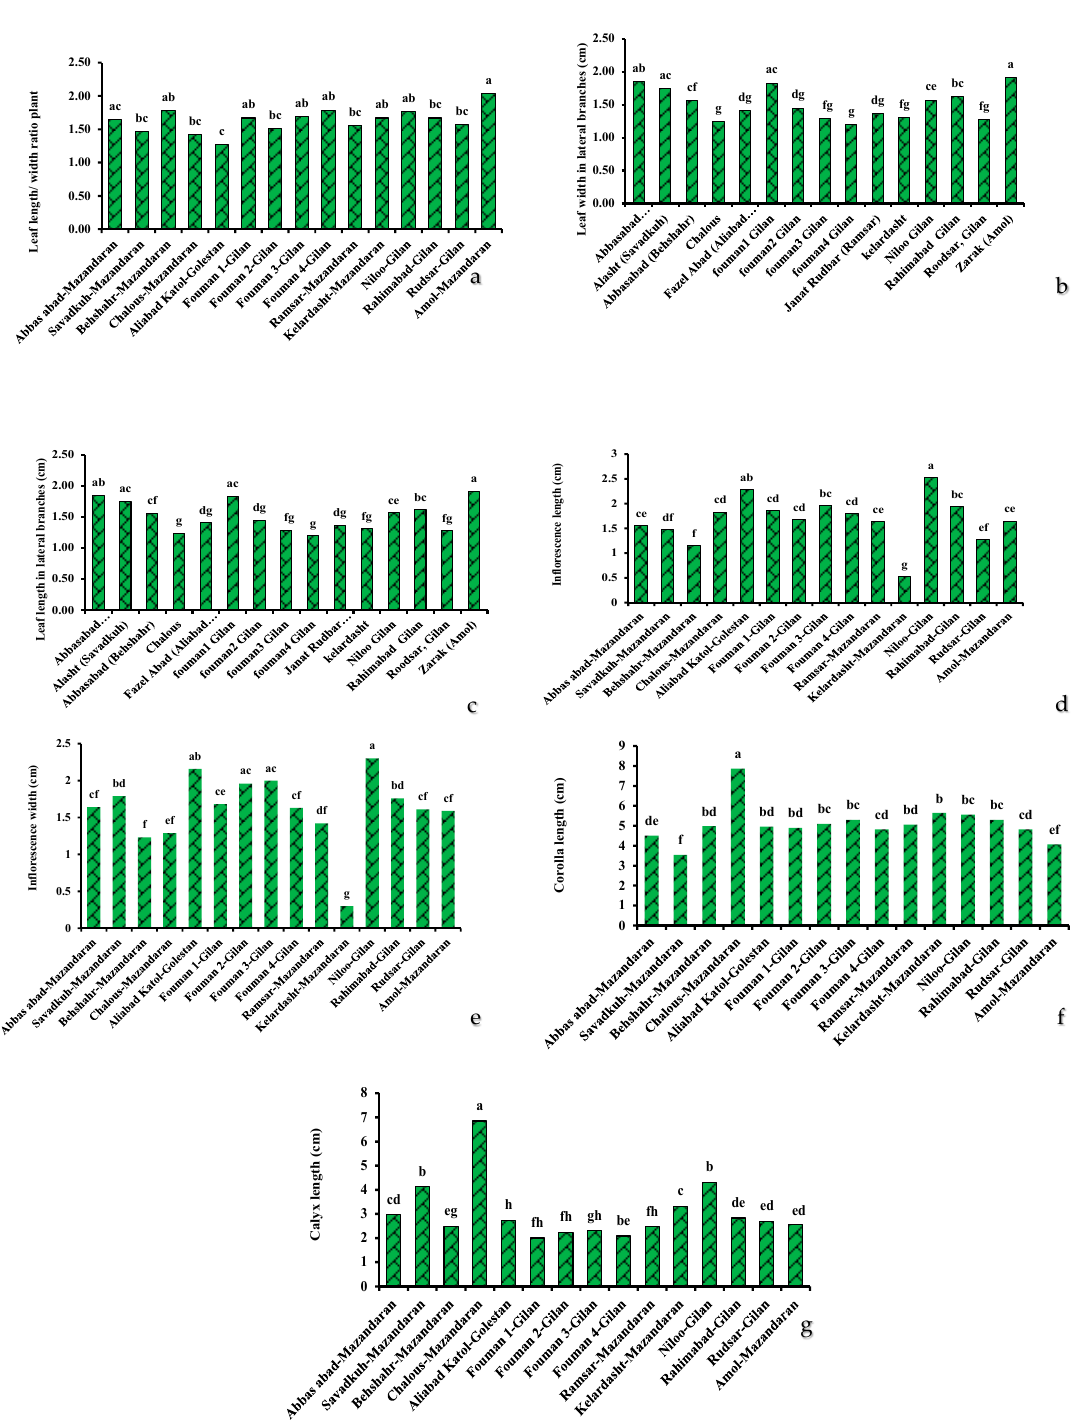
Figure 4. Mean comparison for leaf length-to-width ratio ( a ), leaf width in lateral branches ( b ), leaf length in lateral branches ( c ), inflorescence length ( d ), inflorescence width ( e ), corolla length ( f ), and calyx length ( g ) in different ecotypes of M. aquatica collected from the Hyrcanian hotspot of Iran. Different letters indicate significant differences according to the LSD test at p < 0.05.